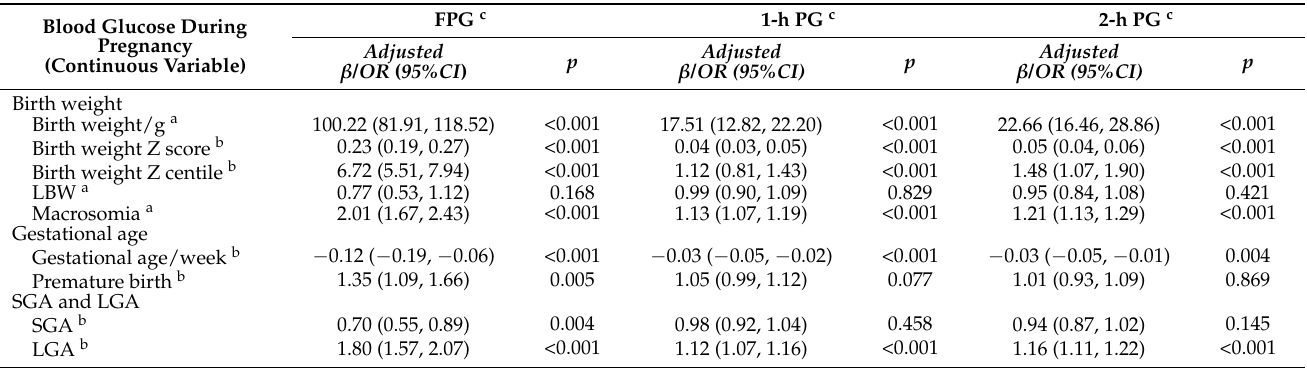
Table 3. Multivariate analysis of blood glucose levels during pregnancy and birth